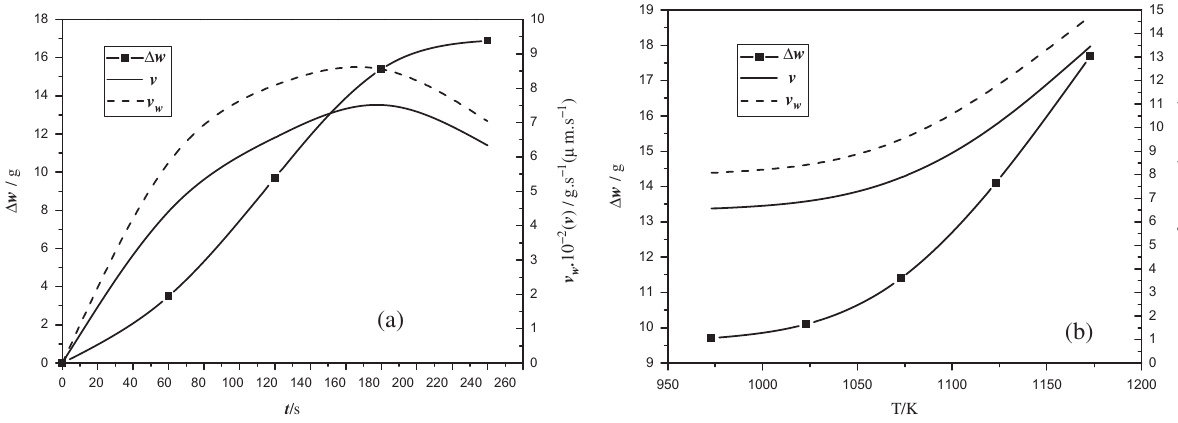
Figure 2: Impacts of time and temperature on the dissolved quantity and the dissolved speed of Cu (a) Temperature of Al is 973 K (b) Contact time of Cu and Al is 120s Δ w – dissolved quantity of Cu, v – translational speed from the Cu surface to Cu inner, v w – dissolved speed of Cu, t – time, T